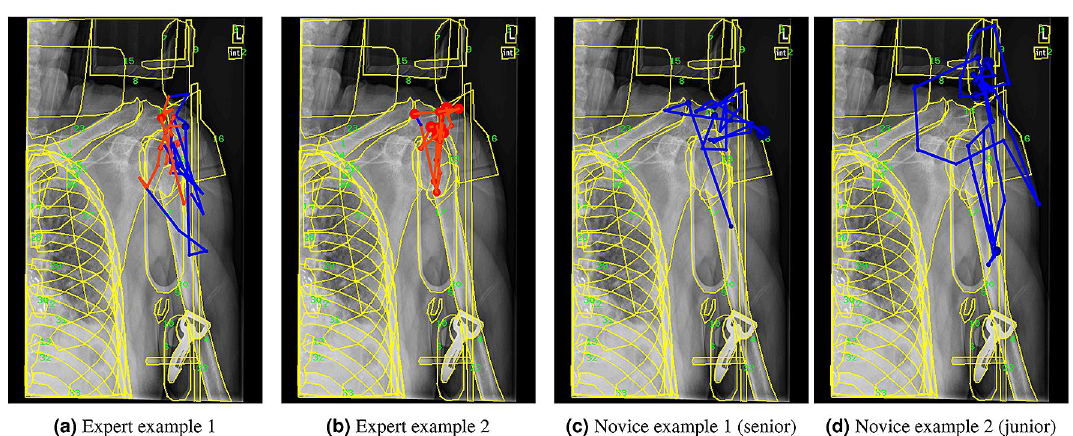
Figure 4. Example eye movement sequences for Task 10. Unlike novices, the experts are not distracted by the non-anatomical structures and closely examine the fracture of the humeral head as shown by the red